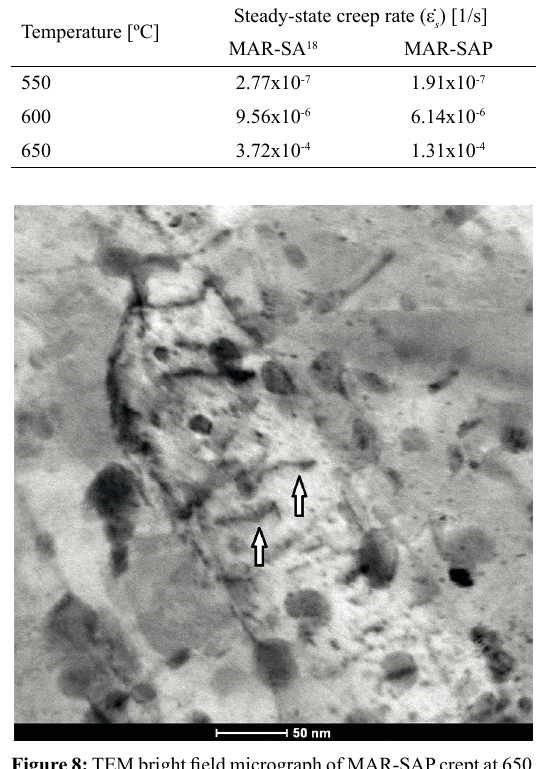
Figure 8: TEM bright field micrograph of MAR-SAP crept at 650 ºC and 500 MPa showing